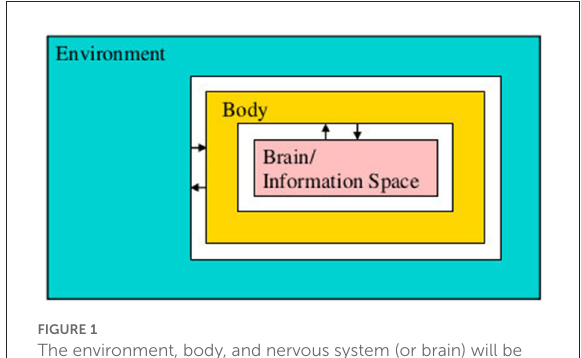
FIGURE1 The environment, body, and nervous system (or brain) will be modeled as inseparable parts of a coupled transition